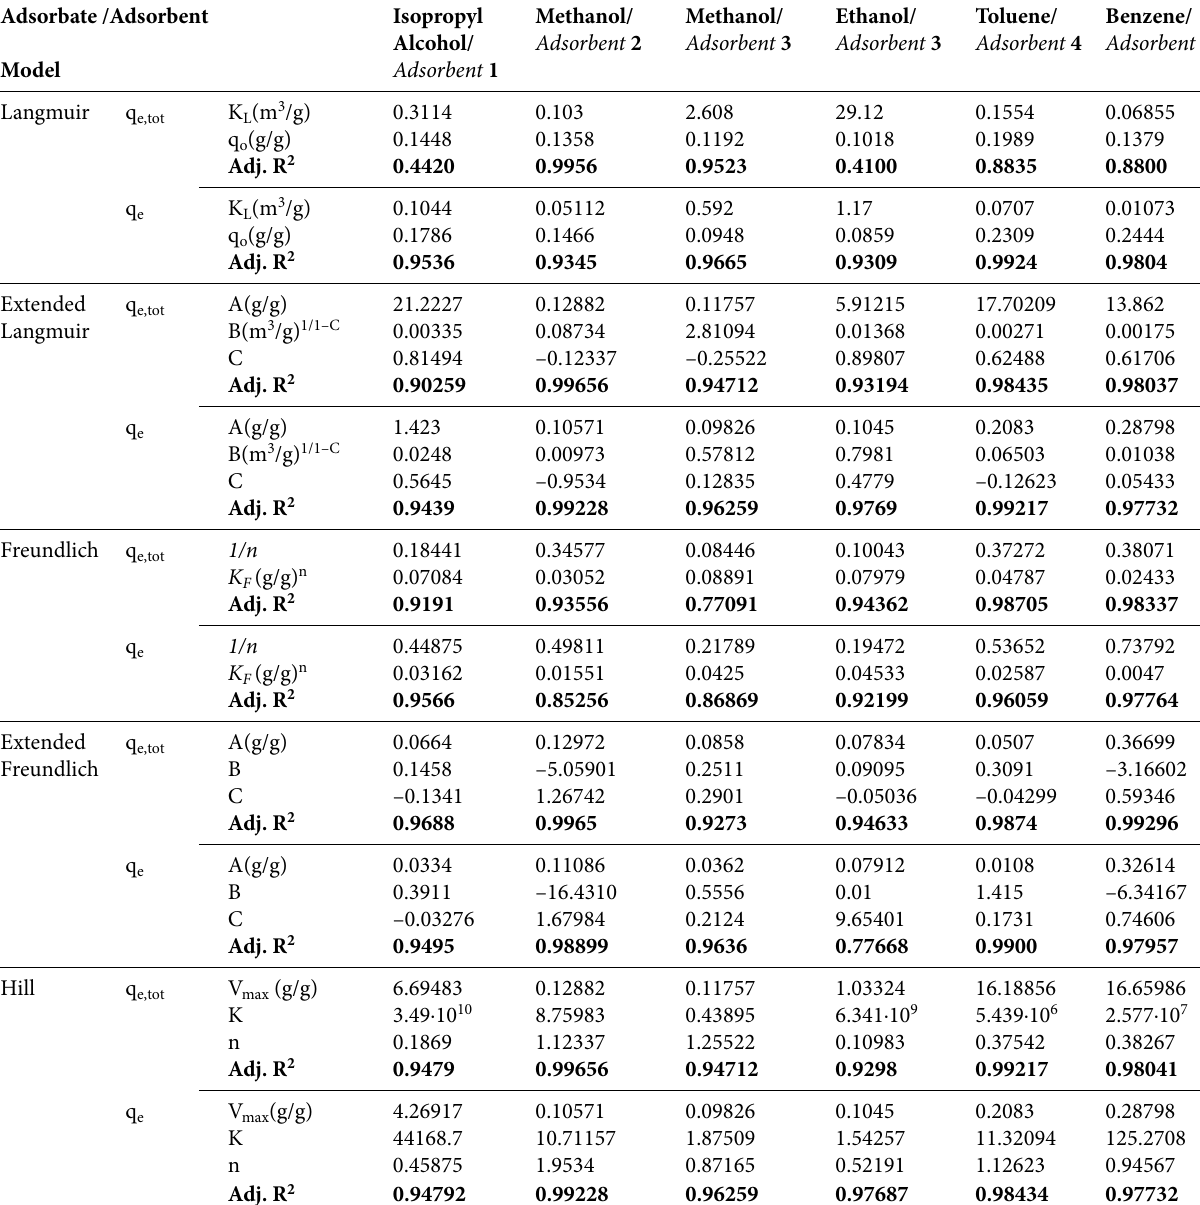
Table 4. Langmuir, Freundlich, extended Langmuir, extended Freundlich and Hill isotherm parameters obtained by non-linear fitting for co-adsorp- tion of VOC (isopropyl alcohol, methanol, ethanol, toluene, benzene) on adsorbents ( Adsorbents 1-4 ) Adsorbate